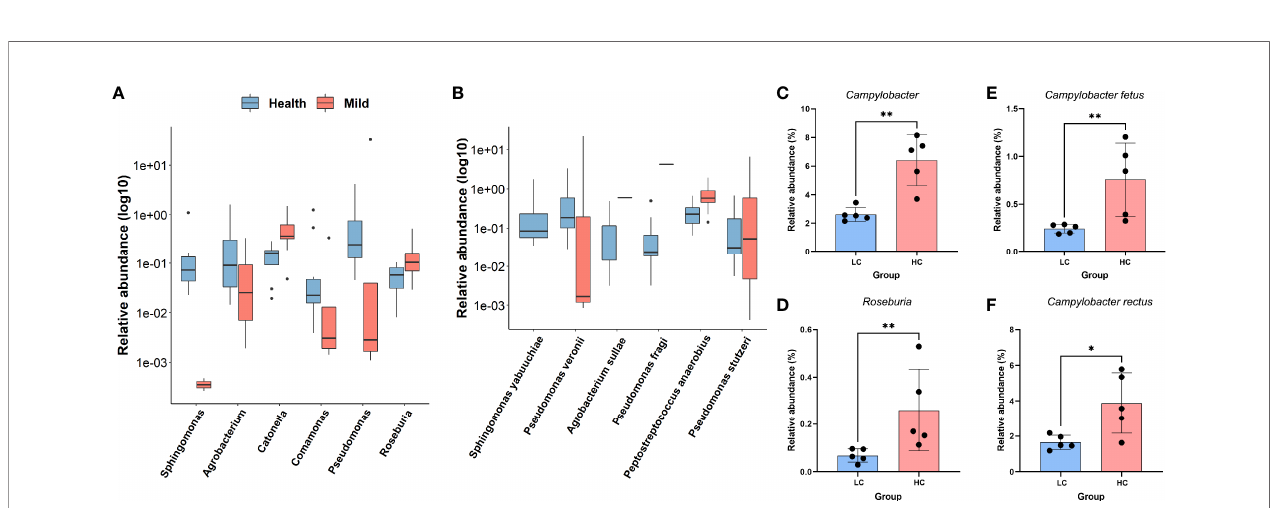
FIGURE 2 | Differentially abundant genera or species in COVID-19 patients and healthy controls. (A) Log10-transformed relative abundance of signi fi cantly different taxa at the genus level. (B) Log10-transformed relative abundance of signi fi cantly different taxa at the species level. (C – F) Relative expression levels of selected genera (C, D) and species (E, F) differing between lower viral titers and higher viral titers. **p<0.01; *p<0.05; Wilcoxon rank-sum